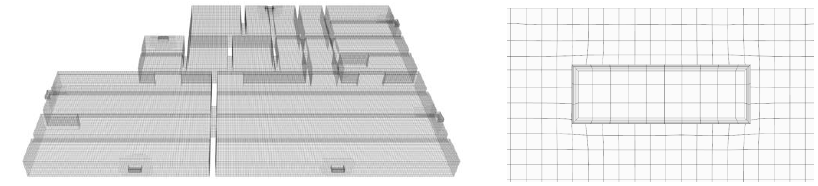
Figure 11. Outline of prism layers and hexahedral meshes prism layers on underfloor space and its opening.